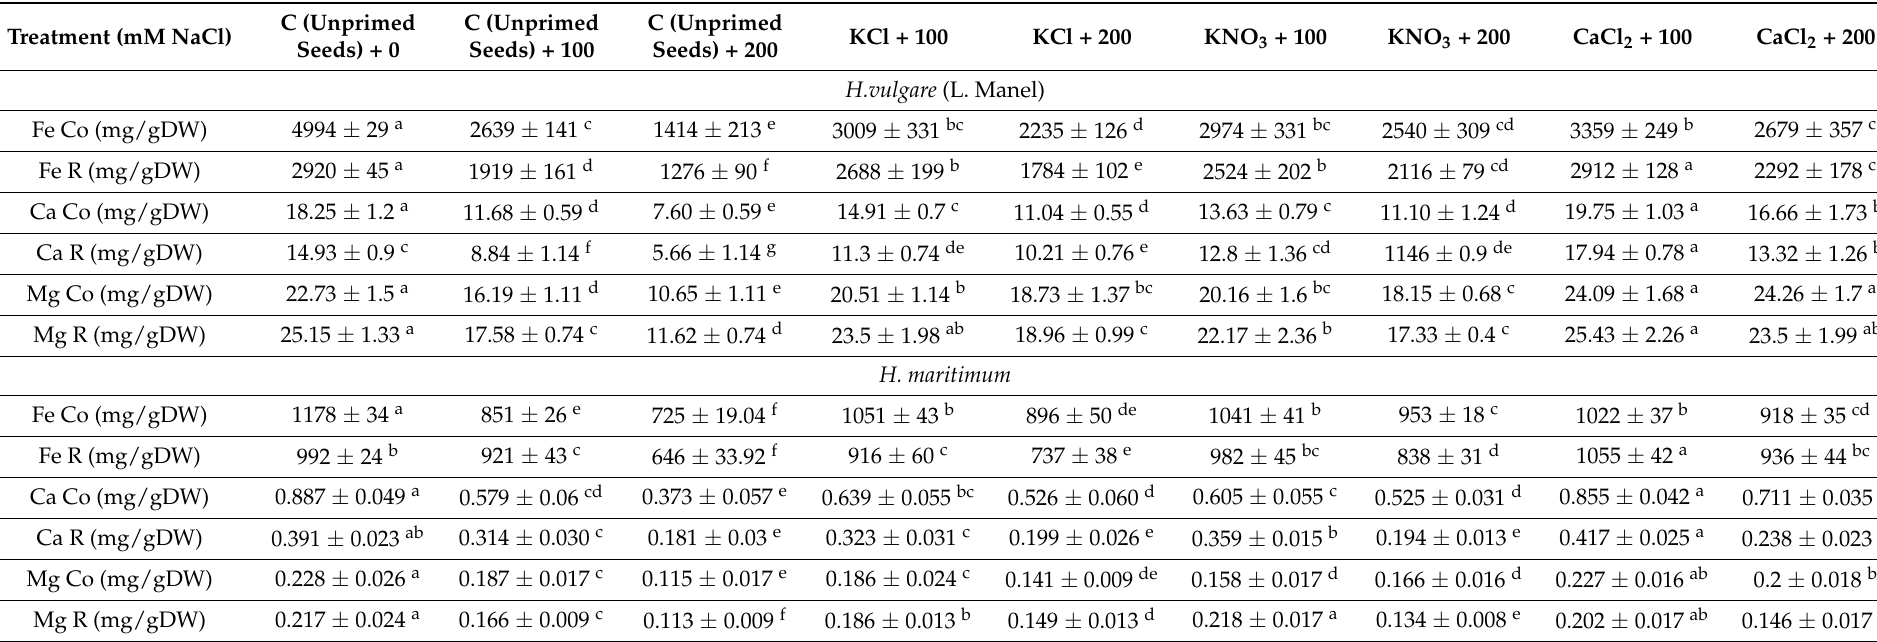
Values are means of 5 independent replicates ± standard error. Data with the same letter are not significantly different at p < 0.05 (Duncan’s